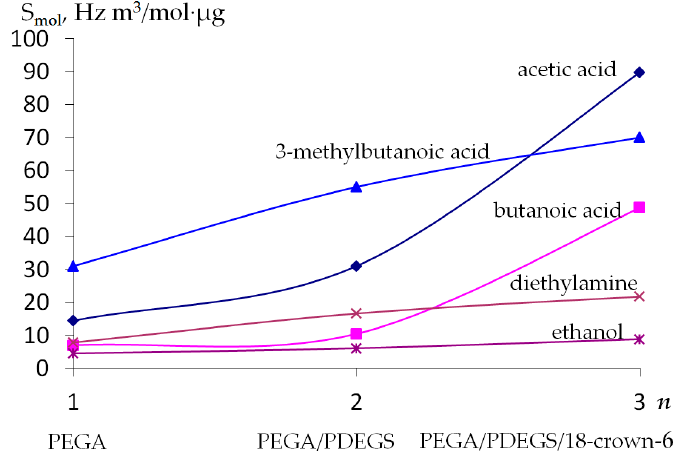
Figure 3. Dependence of the molar-specific sensitivity (S mol ) of microbalances of vapors of various substances on the number of sorbents ( n ) in a polycomposite coating.